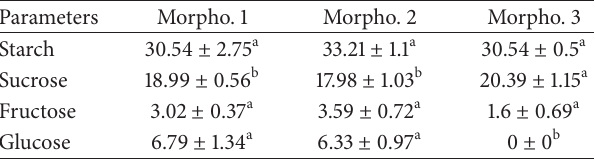
Table2:Carbohydratecomposition(g 100g − 1 )of Cyperusesculentus morphotypes